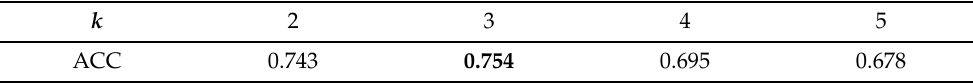
“ACC”: Classification accuracy; “ k ”: Number of consecutive slices for the judgement of a disorder